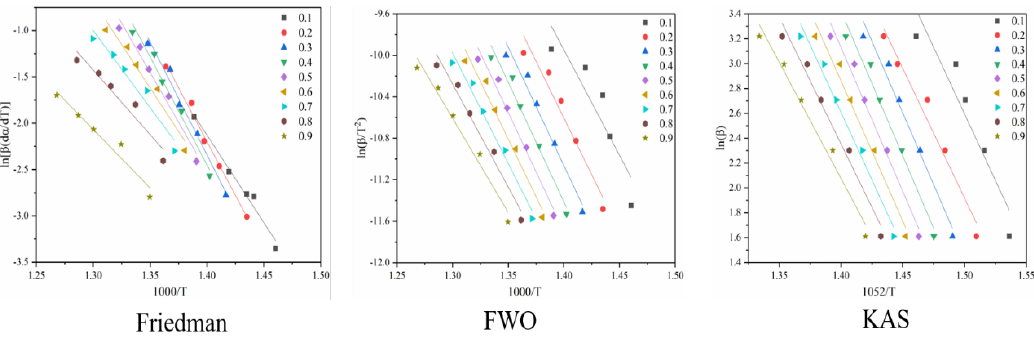
Figure 8. Conversion curve of the second stage of battery material pyrolysis.